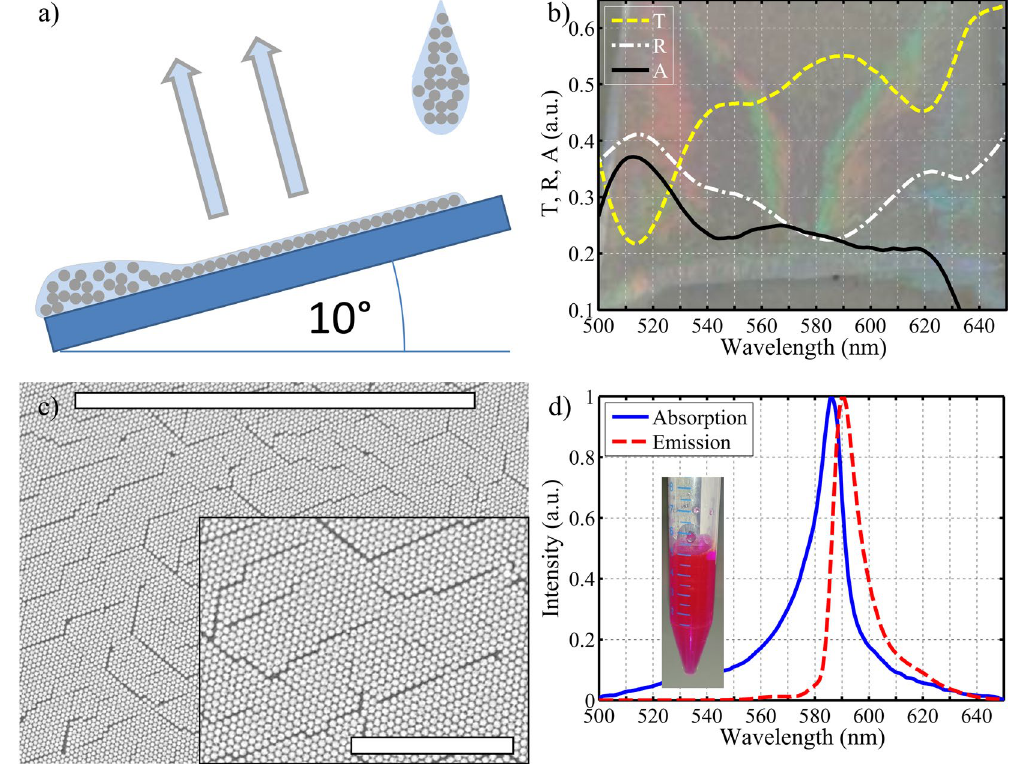
Figure 1. Panel (a) shows a schematics of the convective self-assembly of an hexagonal mono-layer of polystyrene (PS) beads onto a glass substrate. Panel (b) shows transmission, T , reflection, R , and absorption, A spectra for the 2D plasmonic opal with beads of diameter D = 478 nm. The background figure shows the visible iridescence of the structure. Panel (c) shows SEM images at low magnification, with a scale bar of 50 μ m. Panel (d) shows absorption (solid blue line) and emission (dashed red line) spectra of TDBC in NaOH solution (50 μ mol/L), a photography of this TDBC solution is shown in